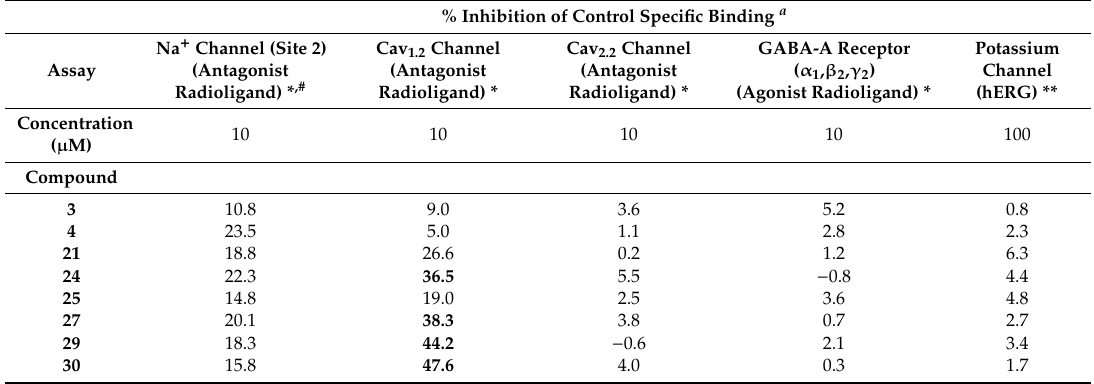
Table 2. In vitro binding assays for several compounds at concentration of 10 µ M or 100 µ M.